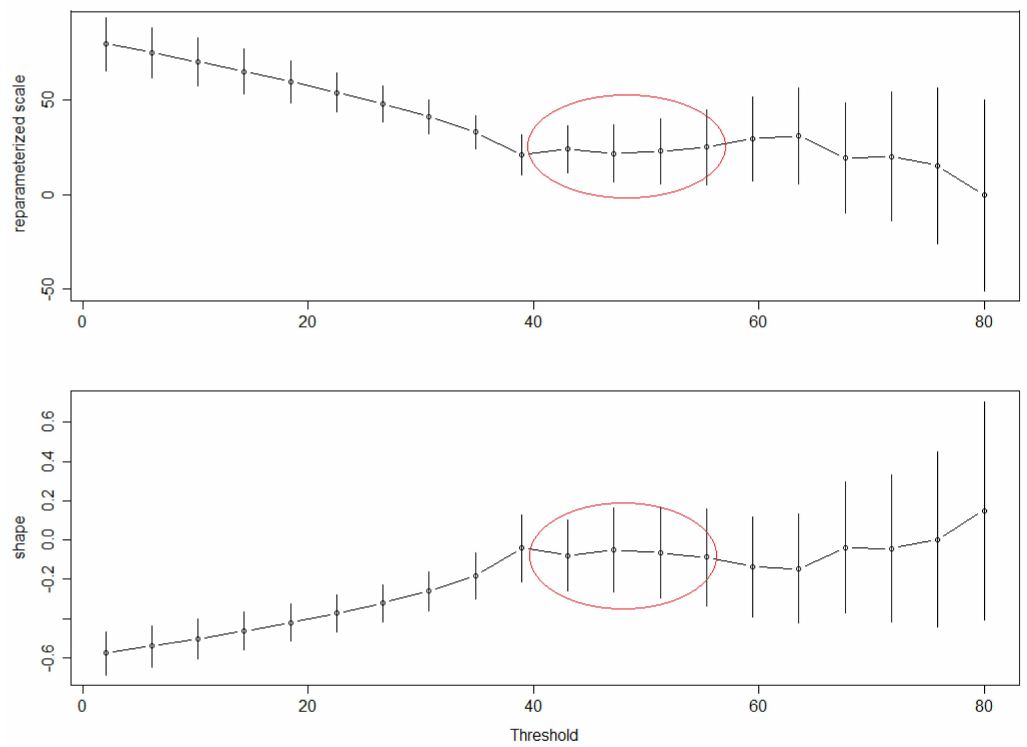
Figure A5. Parameter estimates against threshold for daily rainfall data at Kokoro station (first sub-samples).